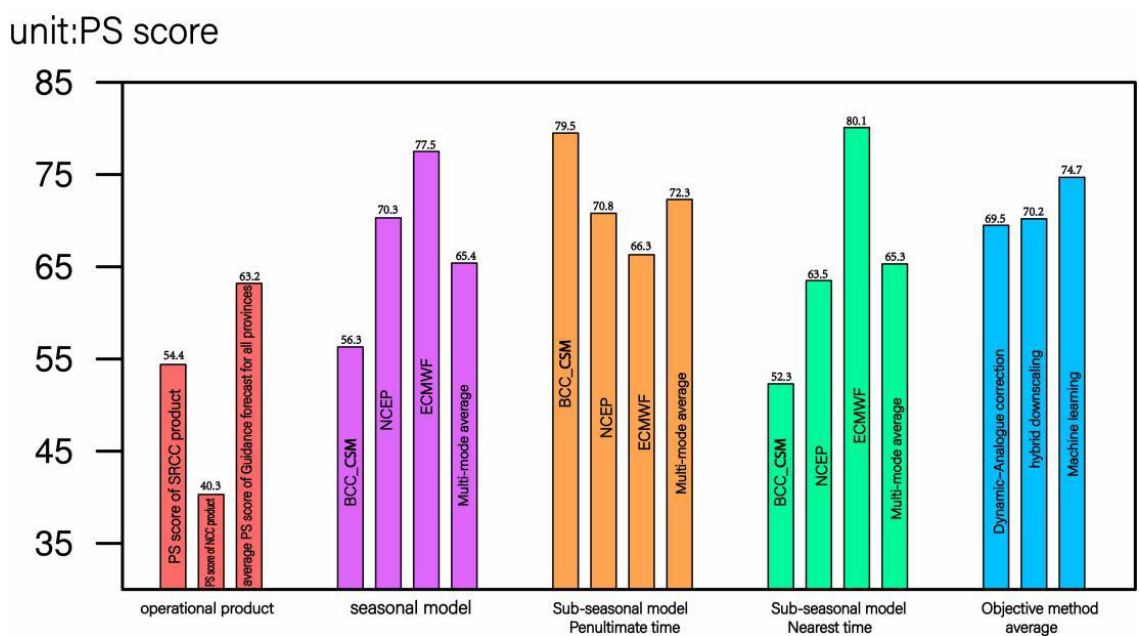
Figure 3. PS scores of June precipitation forecasts from different schemes.